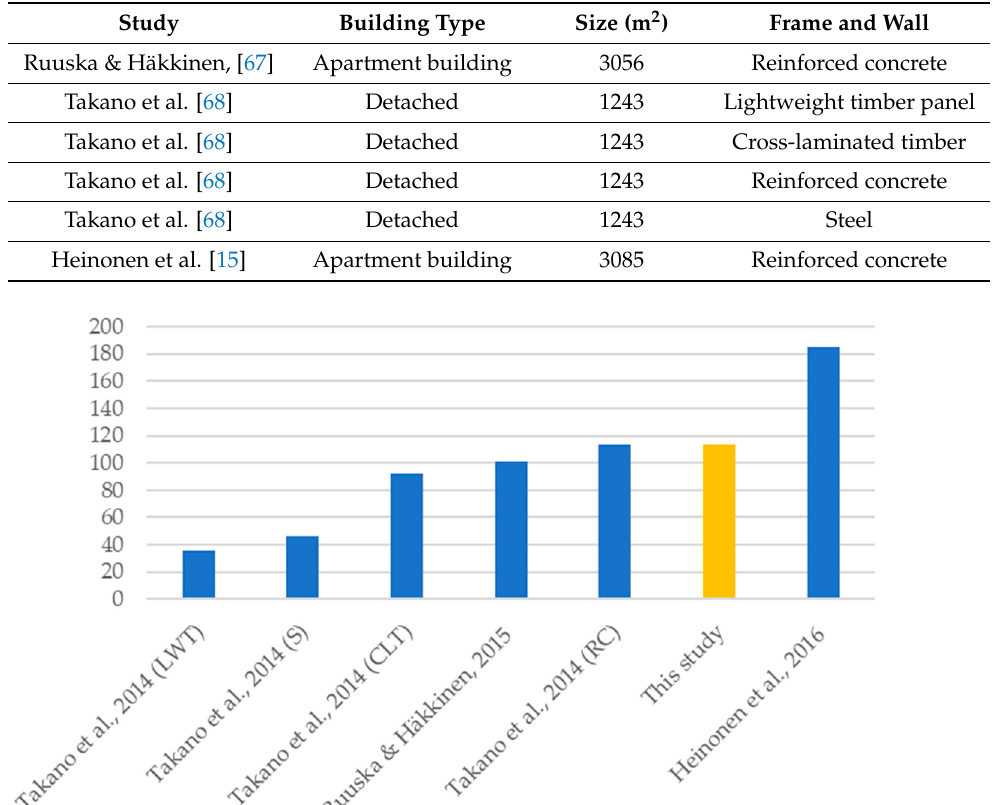
Table 9. Selected previous studies used to position the GWP from the frame/wall structures of the fiberglass house of this study.